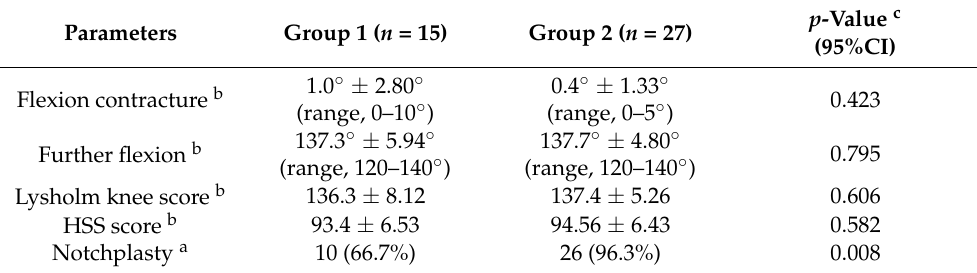
Table 5. Postoperative clinical outcomes between the two groups ( n =